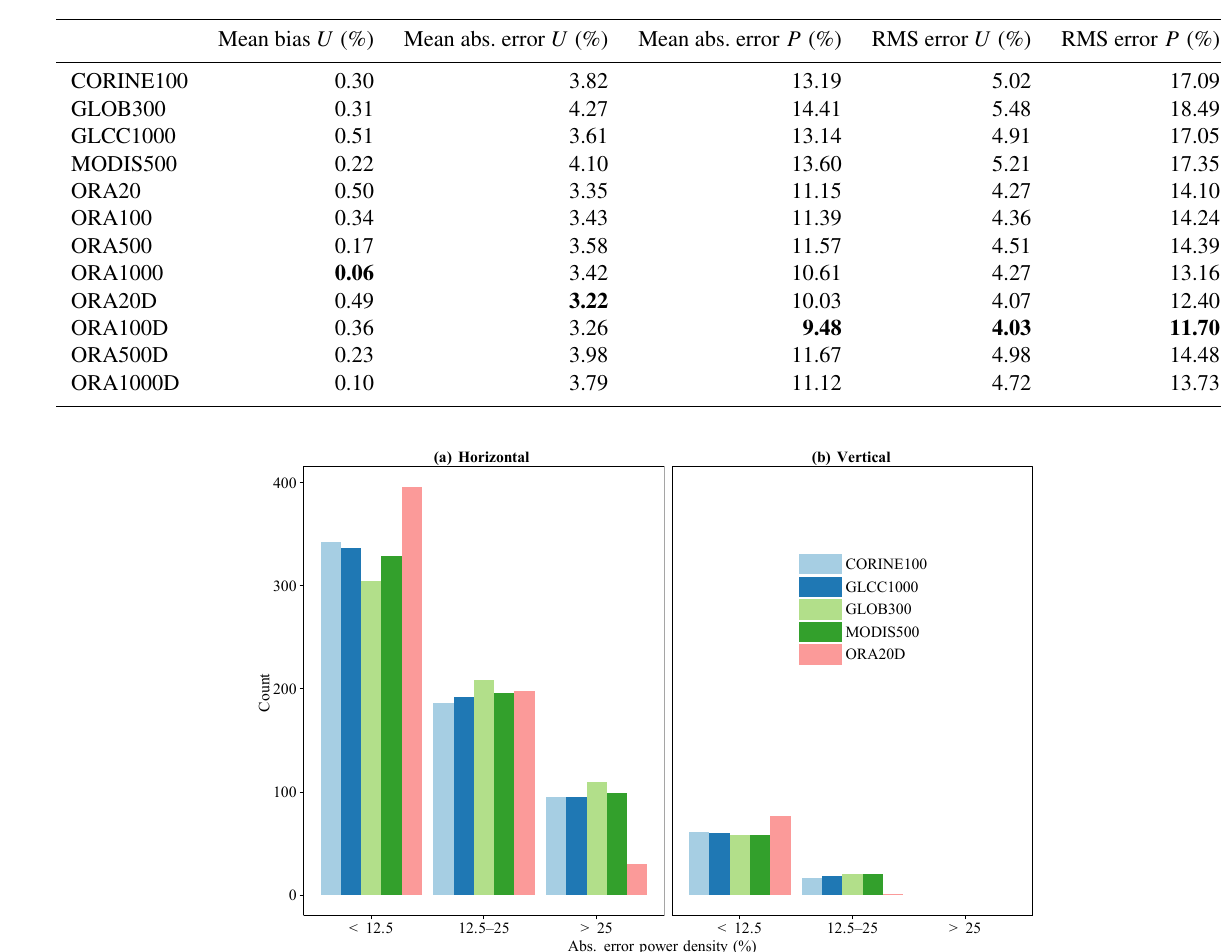
Table 5. Summary of the error metrics using all model runs (702 cross predictions). Defining y as the modelled and x as the observed variable with a line denoting a mean, the mean absolute error is defined as 100 | ( y i − x i ) /x i | , the mean bias as 100( y i − x i ) /x i , and the root-mean-square error (RMSE) in percent of the wind speed U and the power P as metric is denoted in bold.